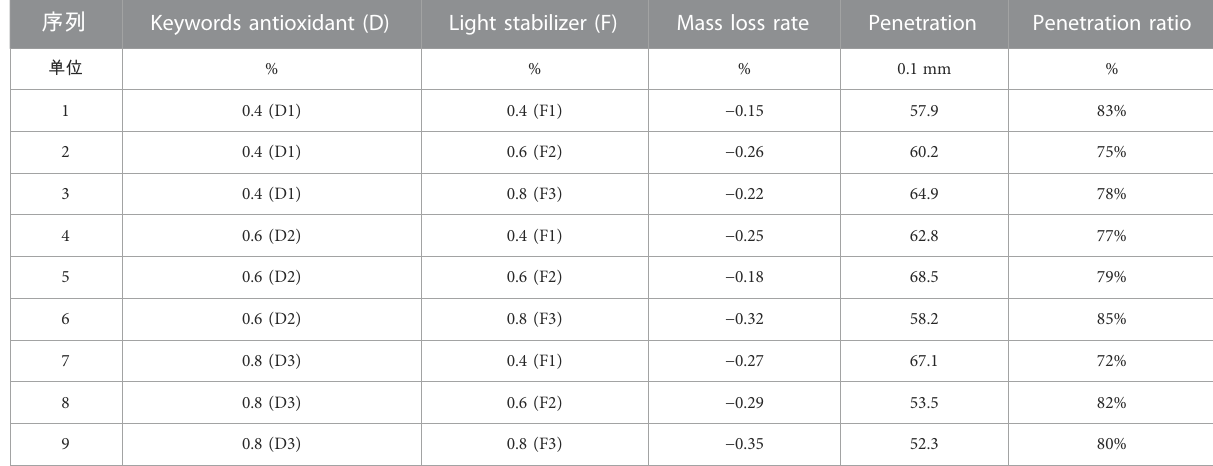
TABLE 11 Test and test results.